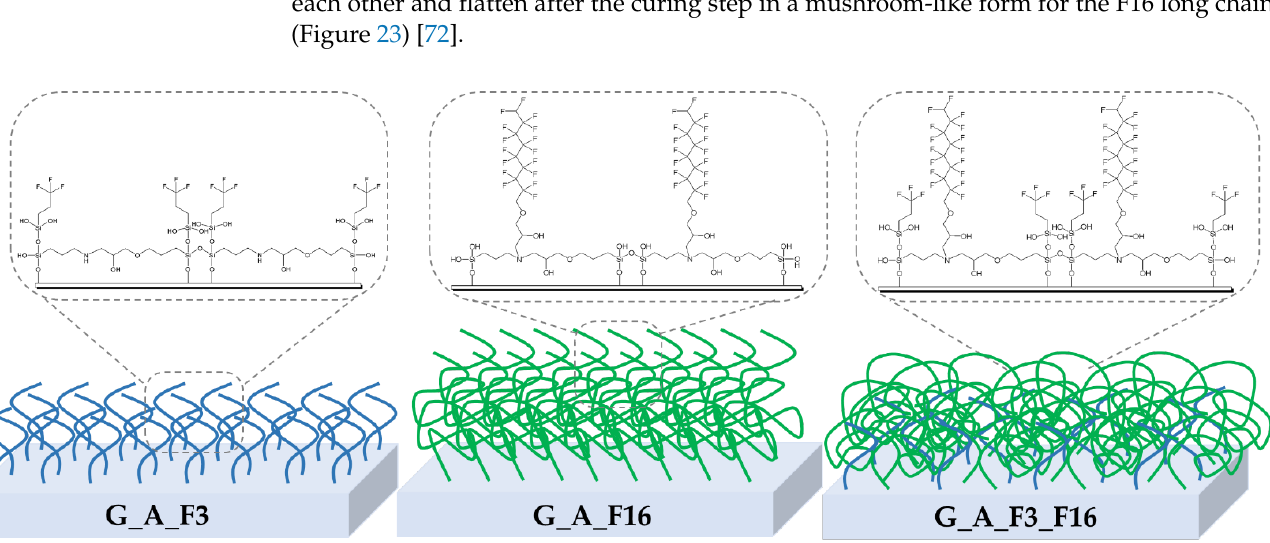
Figure 23. Sketches of F3 and F16 brushes distribution on fluorinated coated glasses.